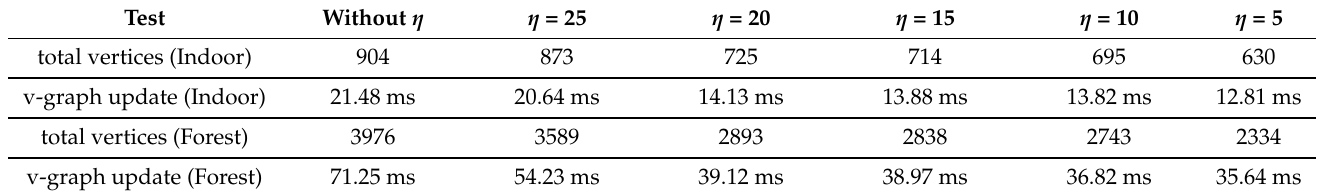
Table 1. Relevances among η , total vertices besides the speed of v-graph